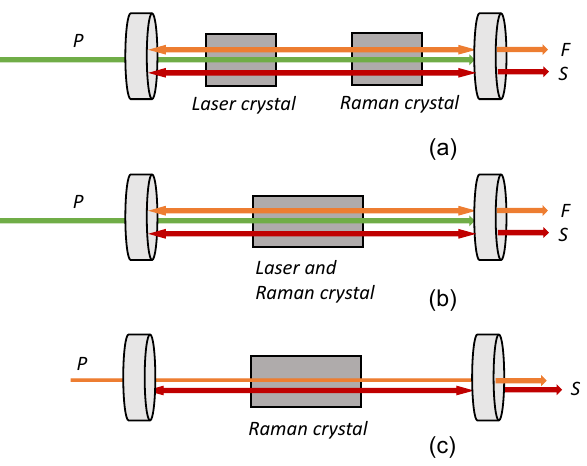
Figure 3. Raman laser ( a ) intracavity, ( b ) self-Raman, and ( c ) external cavity configurations; P, F, S denotes to pump, fundamental, and first Stokes respectively.